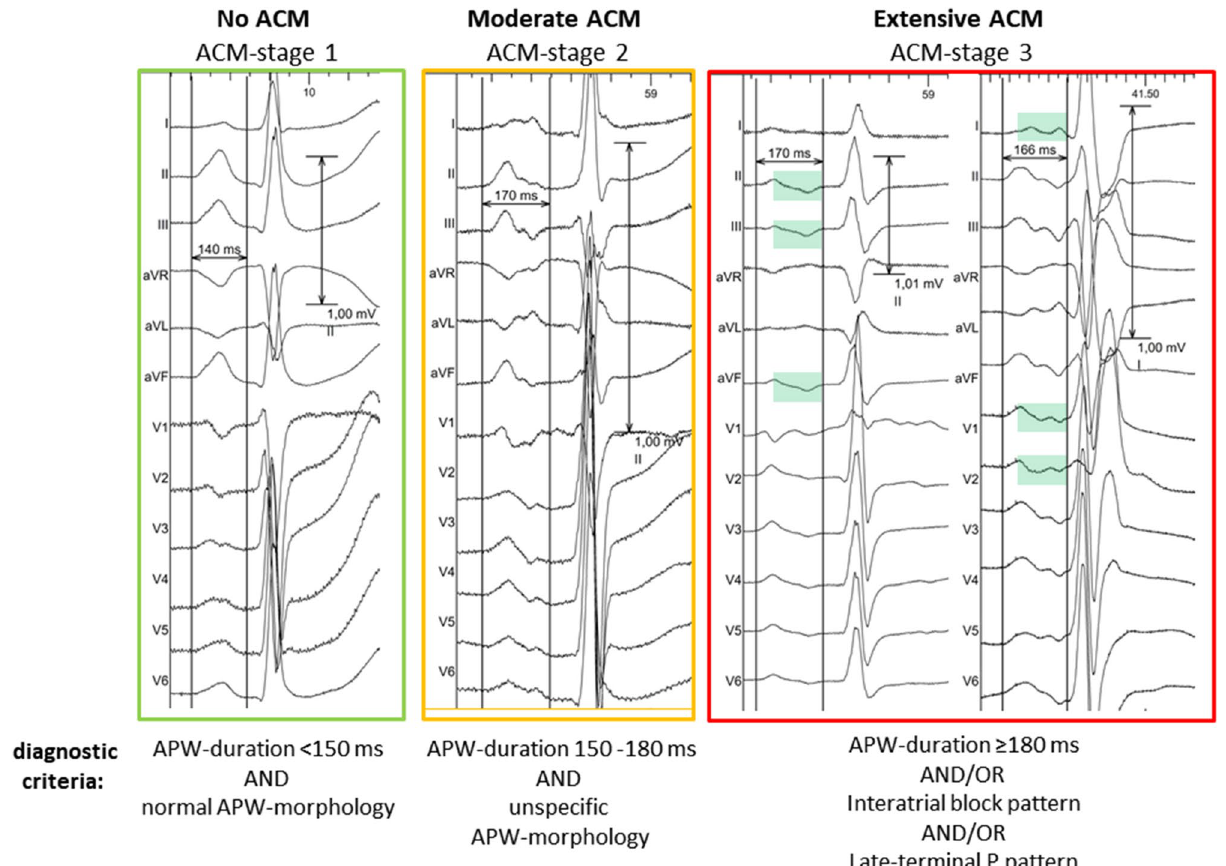
Figure 1. Electrocardiographic diagnosis of atrial cardiomyopathy. Twelve-lead surface ECGs from four representative patients with 100 mm/s sweep speed and amplification of 40–80 mm/mV. In ACM-stage 1 (green box, no ACM), APW-duration is < 150 ms with normal morphology. In ACM-stage 2 (yellow box, moderate ACM), APW-duration is prolonged from 150 to 180 ms with normal or unspecific morphology. ACM-stage 3 (red box, extensive ACM) is diagnosed with prolongation of APW ≥ 180 ms or when pre-specified morphological criteria (interatrial block [IAB] defined as biphasic positive–negative P-waves in 3 of 3 inferior leads II, III and aVF or late-terminal P defined as a positive deflection [reflecting activation of the left atrial appendage] in one or more lateral leads preceded by an isoelectric interval [reflecting ubiquitous low-voltage within the left atrial body]) are met. APW amplified P-wave; ACM, atrial cardiomyopathy. ECGs exported using EP-Labsystem Pro V4.0, Boston Scientific, shown to be related with LAA thrombus as covariates (age, gender, LA diameter and left ventricular function). Matching on the logit of propensity score was performed using the R-based extension-bundle PSMATCHING3 10 . We selected the nearest neighbor method using calipers of width 0.2 of the standard deviation of the logit of the propensity score. The balance in the included covariates was assessed by calculating the standardized mean difference for each covariate. In addition, the total relative imbalance measure L1 was calculated for the origi- nal and the matched data. The histograms of the density of propensity scores for observations before and after matching with overlaid Kernel density estimate, the dot plots of the propensity scores before and after matching, and the dot plots of the standardized mean differences for all covariates before and after matching are given in Supplemental Fig. 1. Variables were compared between groups by taking the matched nature of the data into account, as suggested by Austin 11 . Variables that differed between patients with and without LAA thrombus at a significance level < 0.10 and/or which were judged to be clinically significant were analyzed by conditional logistic regression, using Cox regression analysis with “Time” as a grouping variable. For multivariate models to predict LAA-thrombi, established cardiovascular risk factors that were previously related to atrial thrombo- genesis and/or stroke, were chosen as covariates. The use of oral anticoagulants was included as covariate due to their clinical importance. Future MACCE was calculated using the Kaplan–Meier-method and groups were compared by log rank-test and cox-regression. Follow-up was censored at 720 days to preclude insufficient patient numbers. For all analyses, a two-tailed p < 0.05 was considered significant.